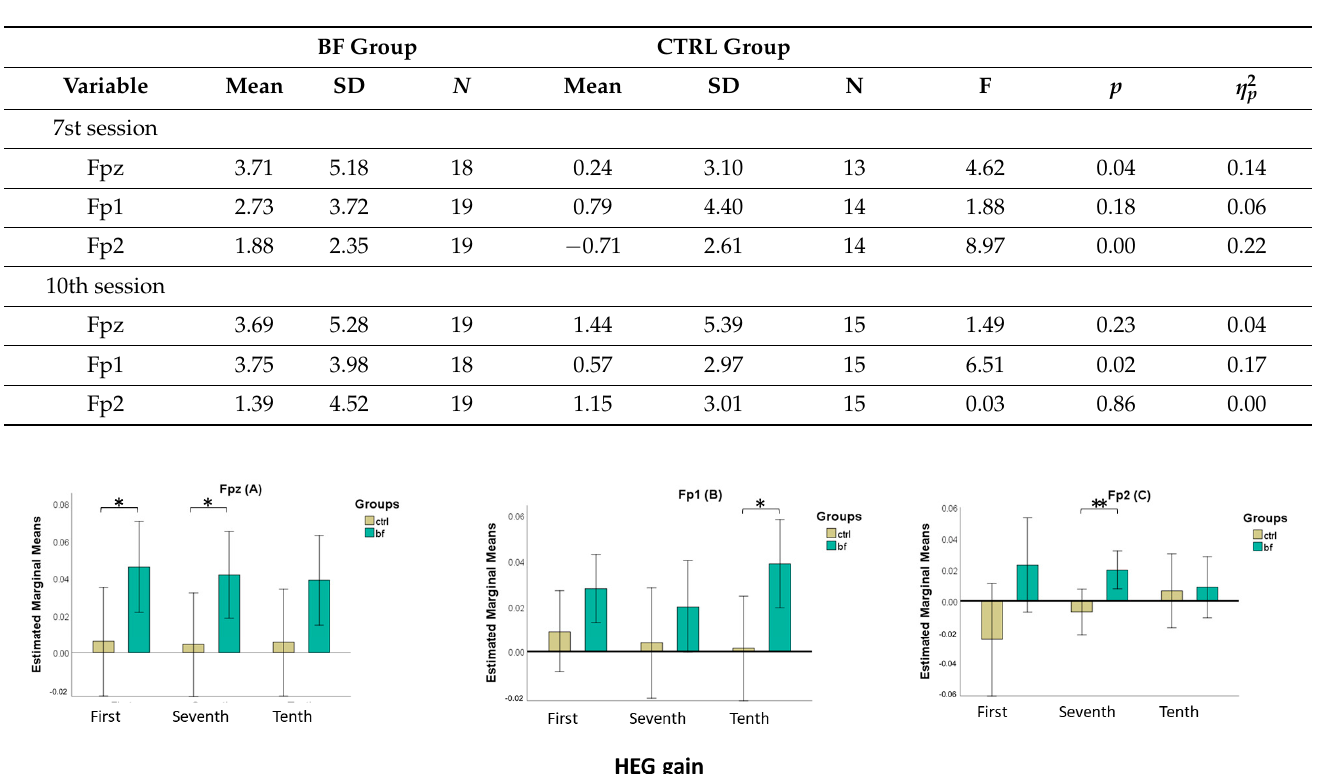
Table 3. Between ‐ group differences in nirHEG percentage values during training sessions for each site and by group.